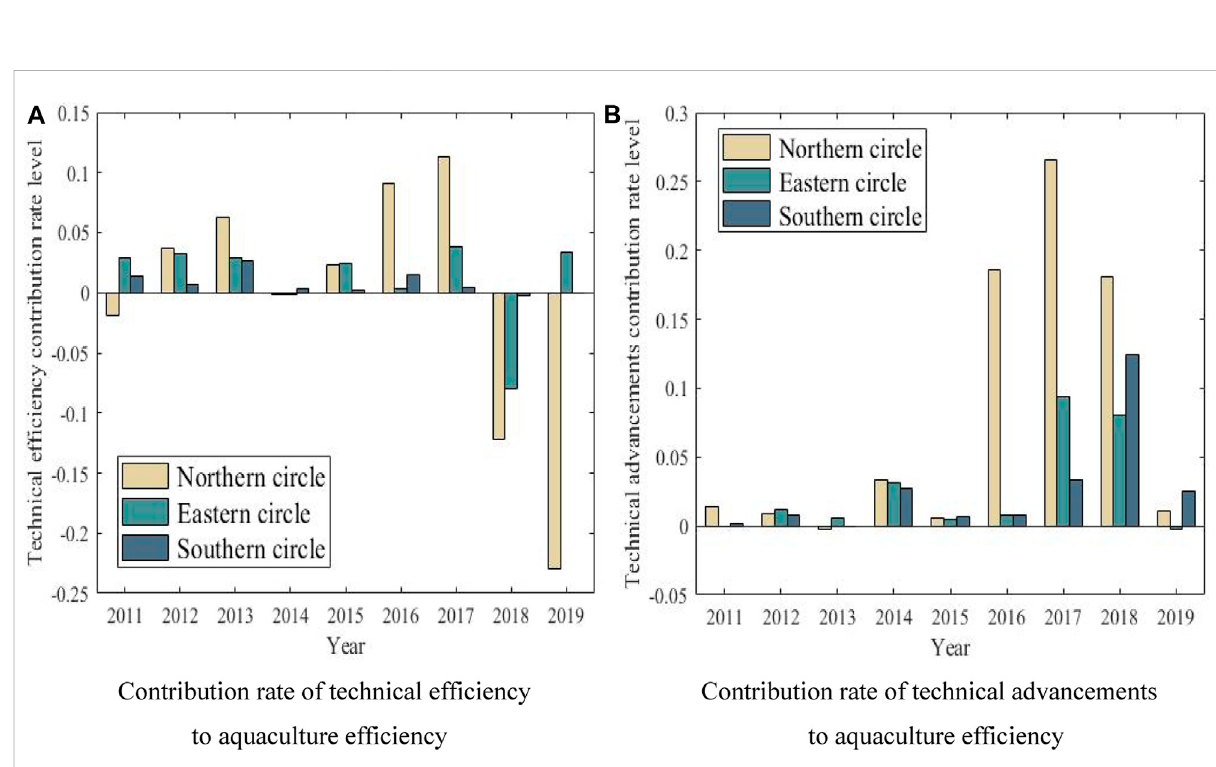
FIGURE 6 Spatial difference of aquaculture ef fi ciency. (A) Contribution rate of technical ef fi ciency to aquaculture ef fi ciency (B) Contribution rate of technical advancements to aquaculture ef fi